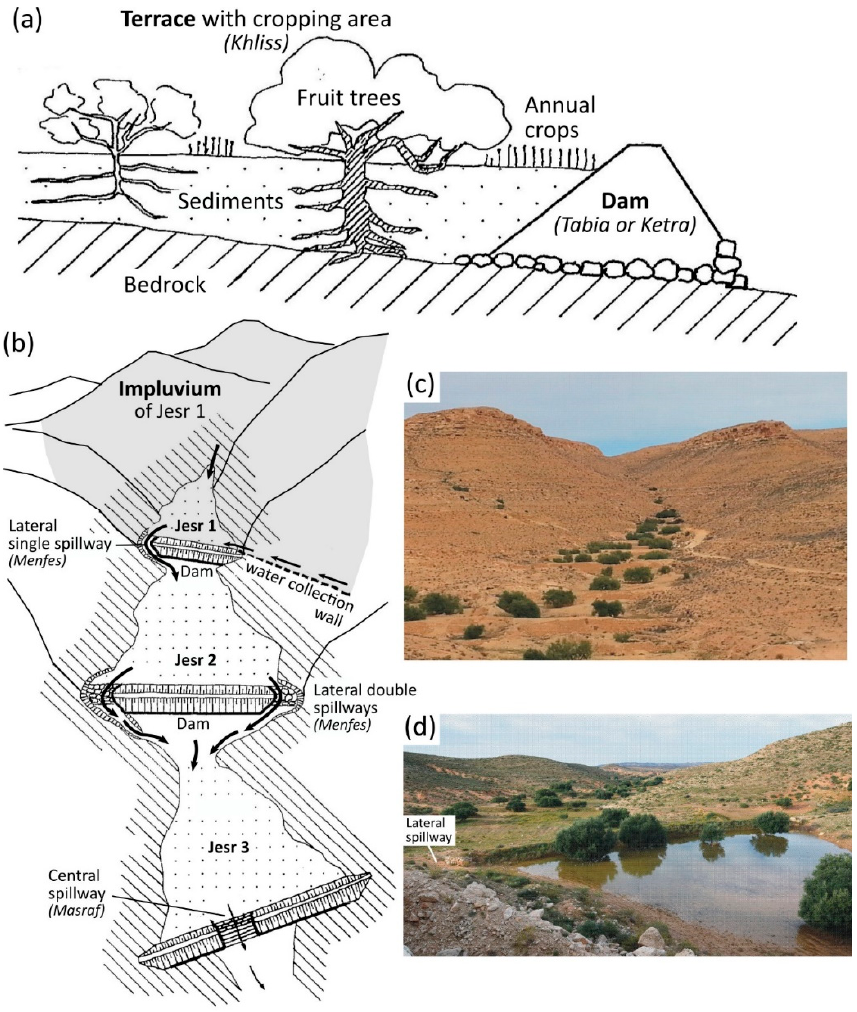
Figure 2. ( a ) View of a Jesr, adapted from Bonvallot [5]; ( b ) general view of Jessour with lateral single spillway (Jesr 1), double spillway (Jesr 2) and central spillway (Jesr 3), adapted from Bonvallot [5]; ( c ) Jessour alignment, note the contrast between arid barren slopes and the bottom of the thalweg in the Jessour (photo: T. Ben Fraj) and ( d ) Jesr retaining part of the rainwater (photo: Tarek Ben Fraj, taken on 22 November 2017 in the Matmata region).